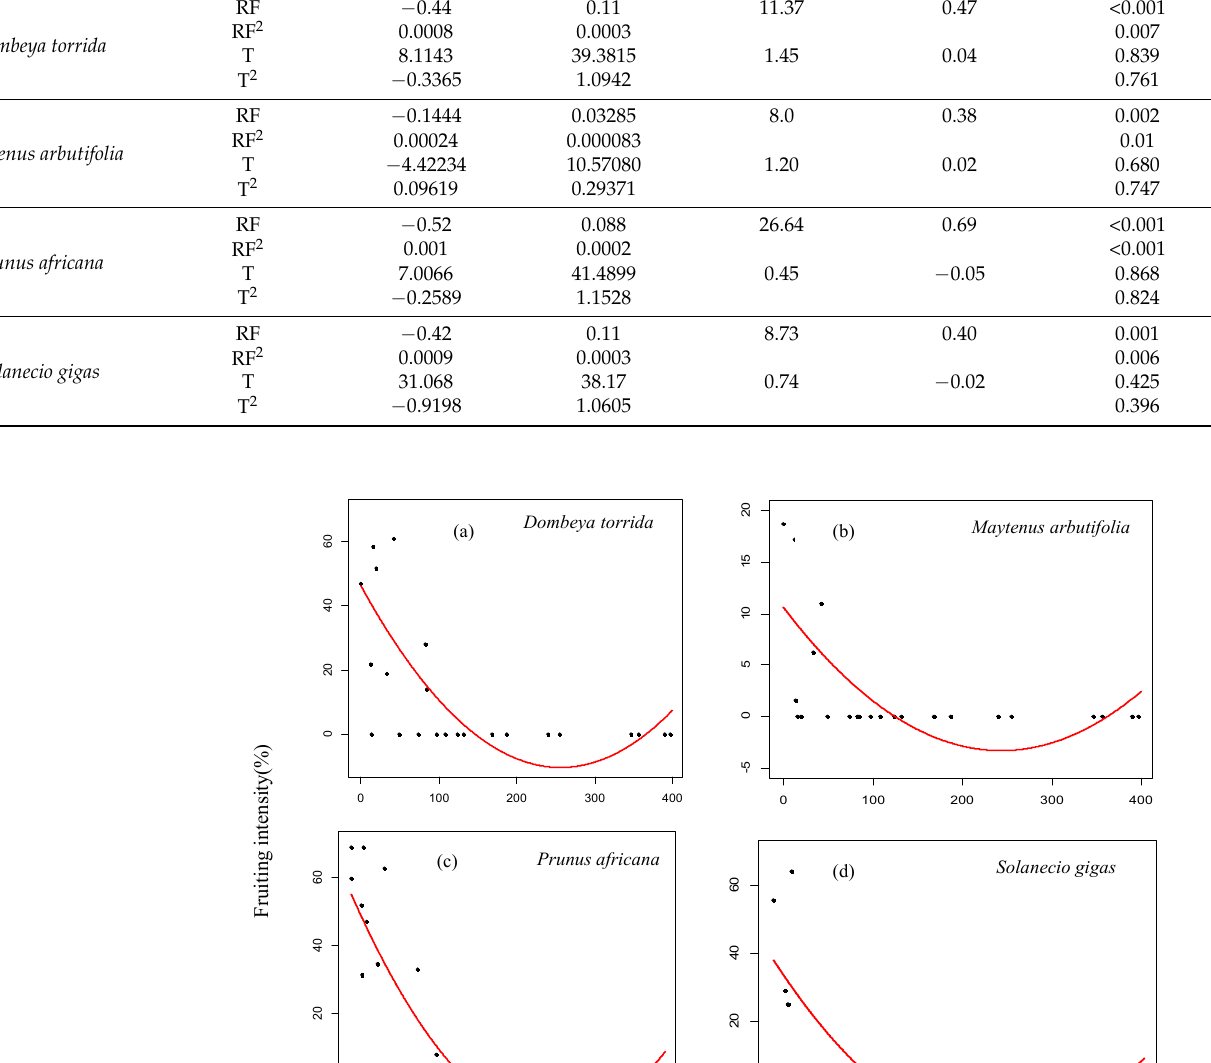
Table 4. The non-linear quadratic polynomial regression model fits showing the effect of monthly rainfall (RF) and average monthly temperature (T) on the fruiting percentage of tree species.